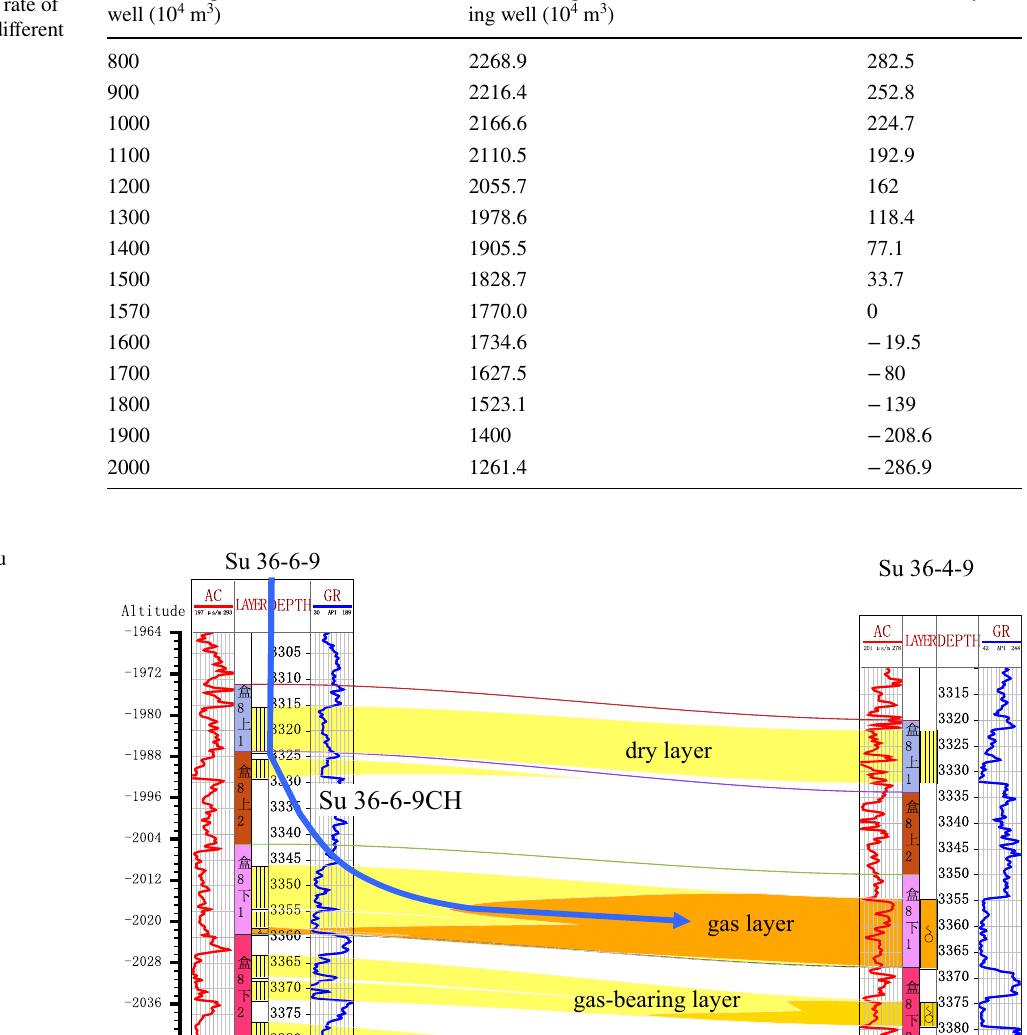
accumulative production rate of sidetracking well under different old gas well cumulative production rate